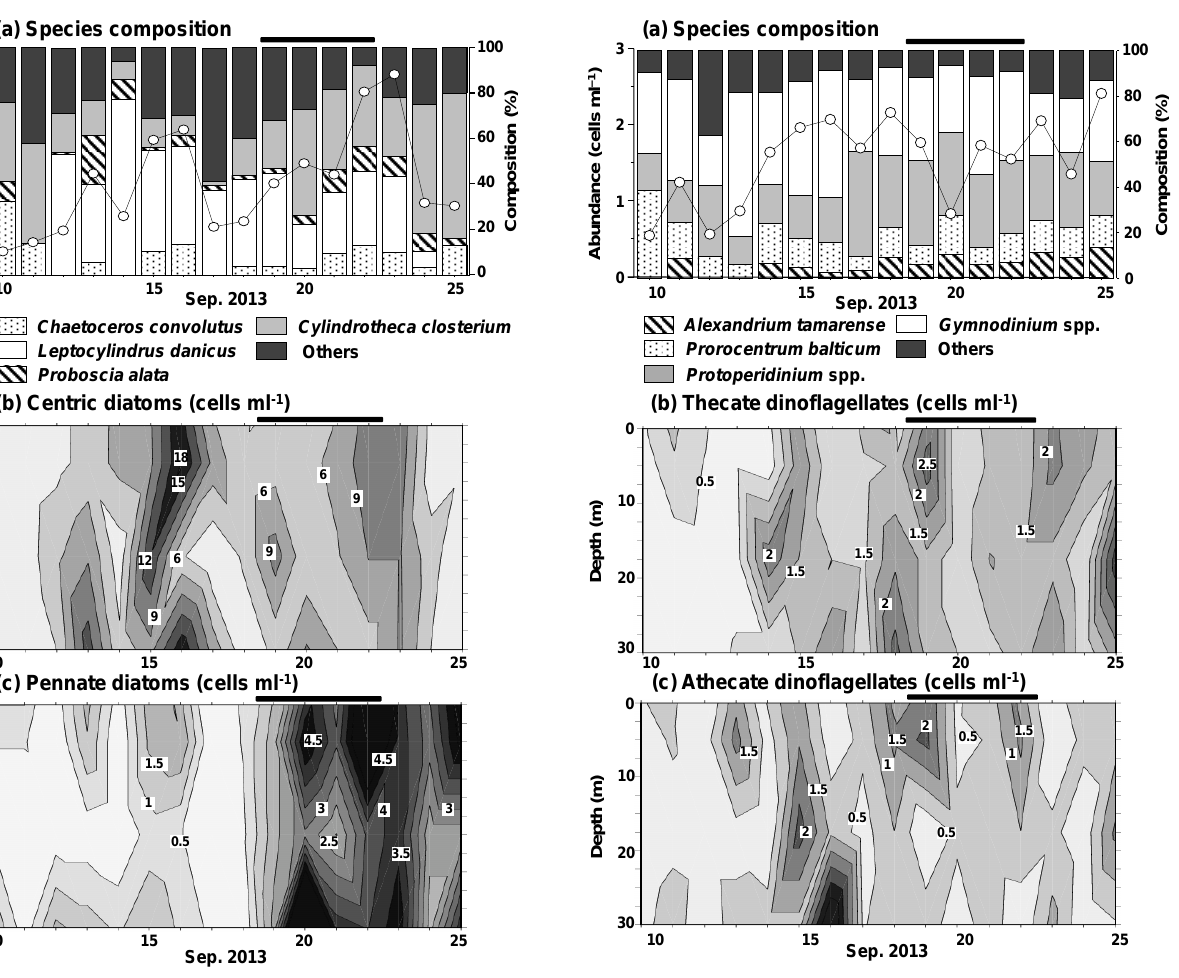
Figure 3. Temporal changes in cell density and species compo- sition of total diatoms (a) , the vertical distribution of centric di- atoms (cellsmL − 1 ) (b) and pennate diatoms (cellsmL − 1 ) (c) in the Chukchi Sea during the period from 10 to 25 September 2013. In (a) , values represent the mean of diatom abundance between 0 and 30m. Solid bars indicate the timing of a strong wind event.